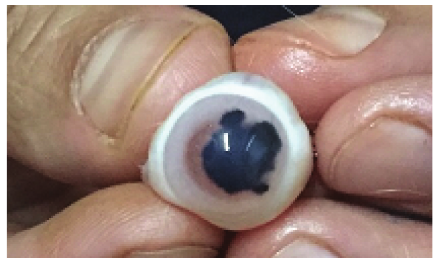
Figure 7: A photomicrograph of rabbit cornea group II, showing the layers of the cornea. Substantia propria contains black pigment between anterior two-thirds and posterior one-third of the cornea (arrow) with single layer of endothelial cells. Notice no infiltration of inflammatory cells in the surrounding layer. H&E ×